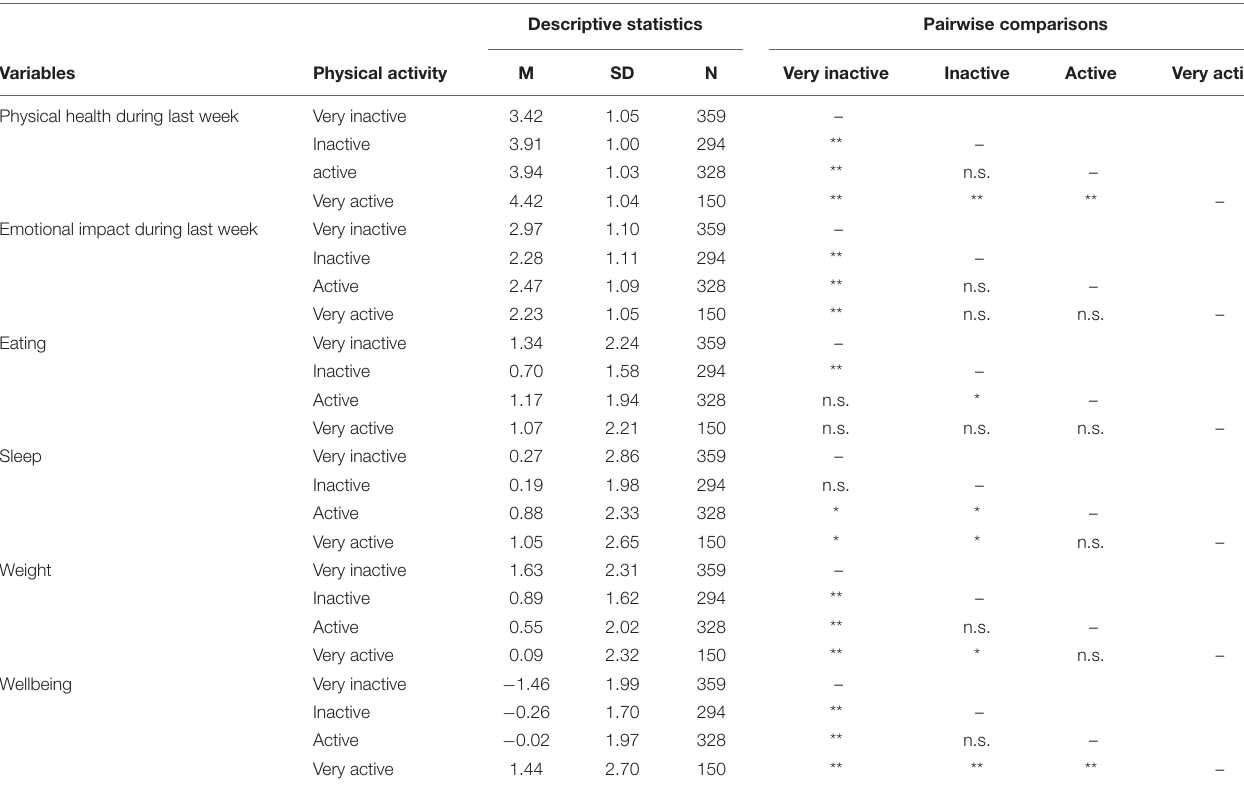
TABLE 1 | Descriptive statistics and pairwise comparisons considering reported changes in participants’ physical